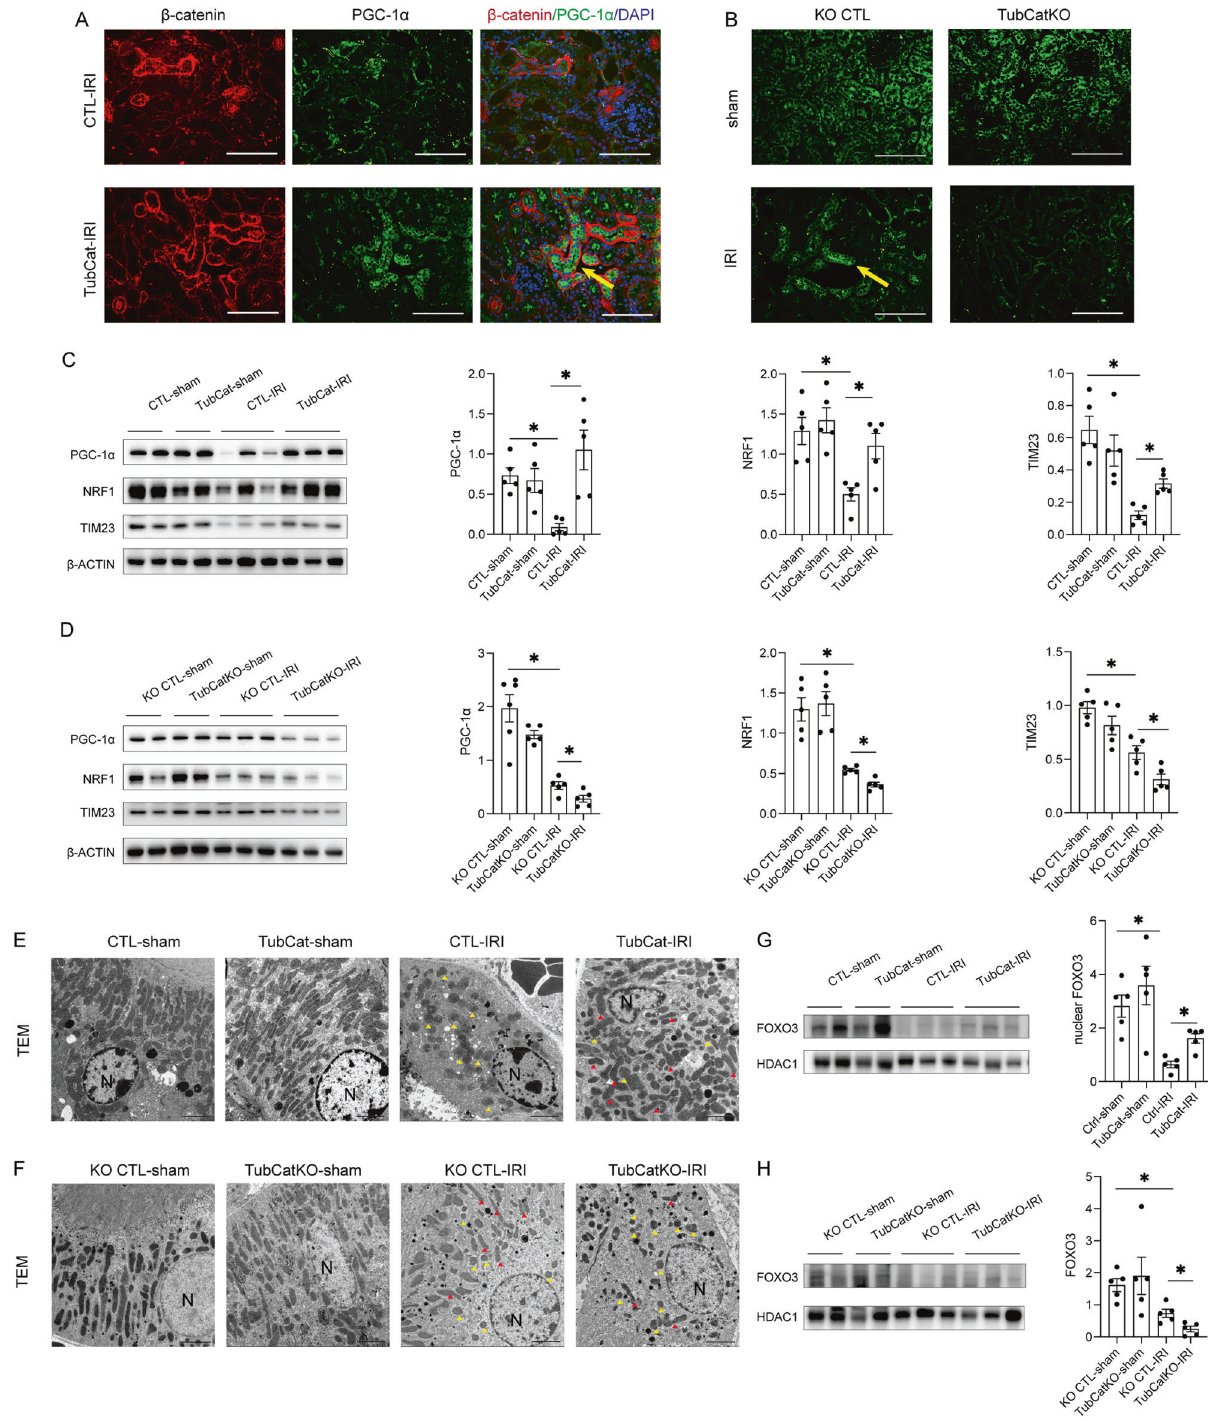
Fig. 5 β -catenin restores tubular mitochondrial biogenesis in IRI-induced AKI. A Double-immuno fl uorescent staining of β -catenin (red) and PGC-1 α (green) in kidney section from TubCat-IRI mice. DAPI (blue) reveals nuclear staining, and yellow arrow denotes co-localization of β -catenin and PGC-1 α . Scale bar = 100 μ m. B Immuno fl uorescent staining of PGC-1 α (green) in kidney cortex from TubCatKO-IRI mice. Yellow arrow indicates PGC-1 α -positive tubule. Scale bar = 100 μ m. C Representative western blots and their quanti fi cation of mitochondrial marker TIM23 and mitochondrial biogenesis regulators (PGC-1 α , NRF1) in kidney cortical lysates in TubCat-IRI mice. * p < 0.05; n = 5 in each group. D Representative western blots and their quanti fi cation of TIM23, PGC-1 α and NRF1 in kidney cortical lysates in TubCatKO-IRI mice. * p < 0.05; n = 5 in each group. E , F Representative transmission electronic microscopy images in TubCat-IRI mice ( E ) and TubCatKO-IRI mice ( F ). Yellow arrowheads are swollen mitochondria, red arrowheads refer to intact mitochondria. N, nucleus. Scale bar = 2 μ m. G , H representative Western blot of FOXO3 in kidney nuclear fraction of TubCat-IRI and TubCatKO-IRI group, HDAC1 was used as nuclear protein loading control. * p < 0.05. n = 5 in each group.